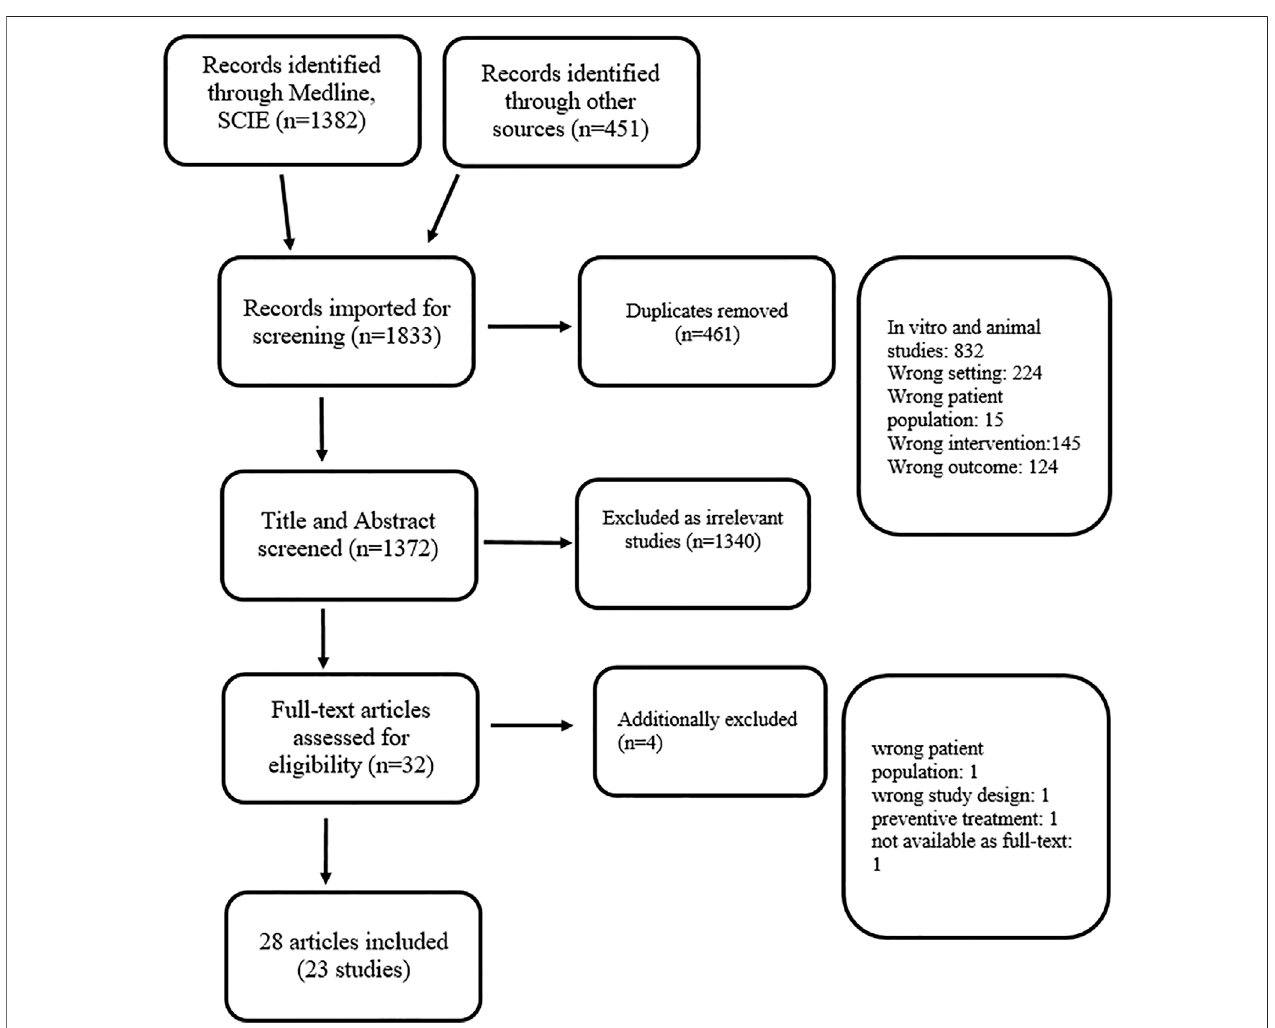
FIGURE 1 | PRISMA fl ow diagram for systematic review, Novel therapies for the treatment of Drug-induced liver injury.